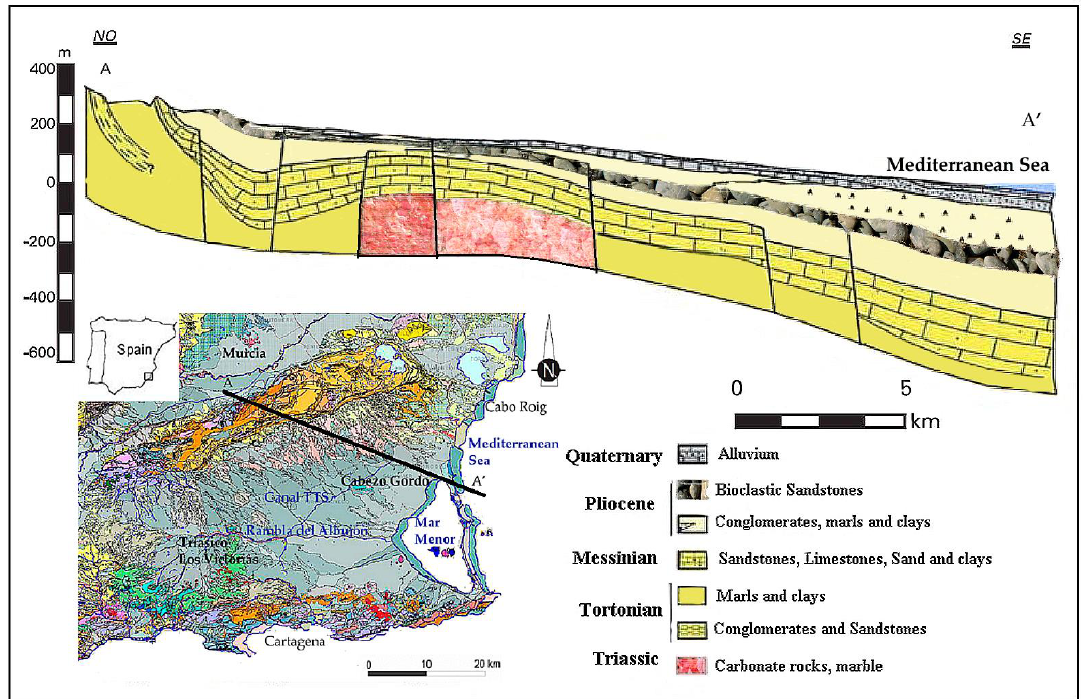
Figure 2. Geological map of the study area and cross-section.